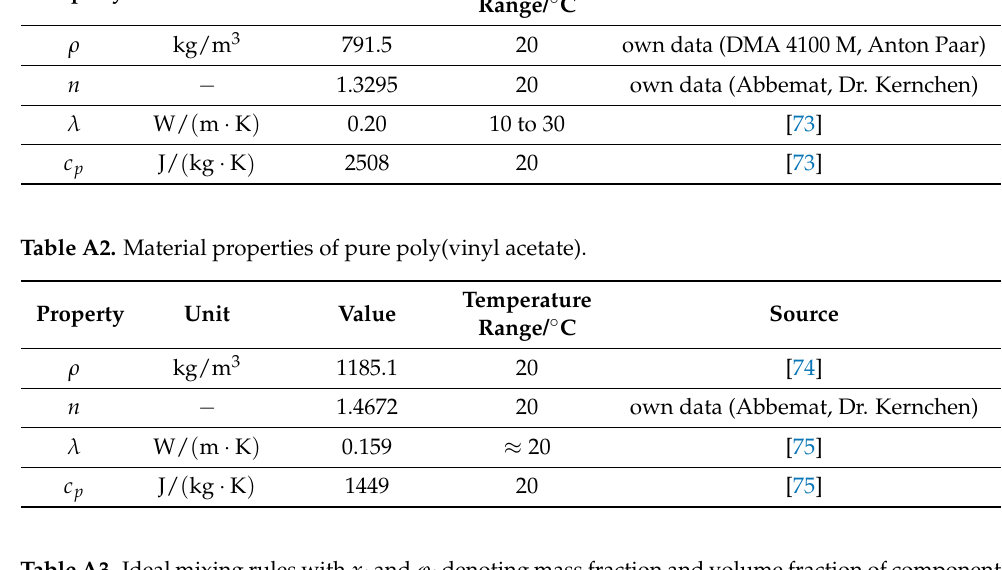
Table A3. Ideal mixing rules with x i and ϕ i denoting mass fraction and volume fraction of component i ,